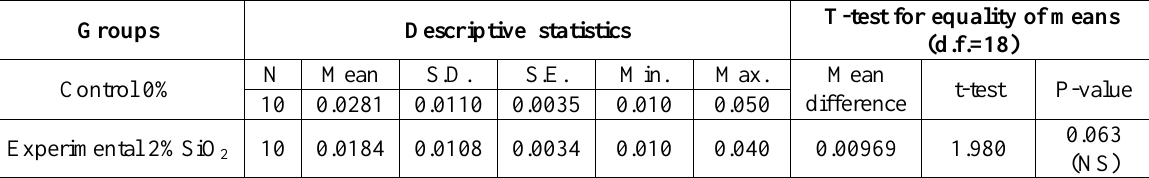
Table 6: Descriptive summary and T-test for water solubility (mg/cm 2 )